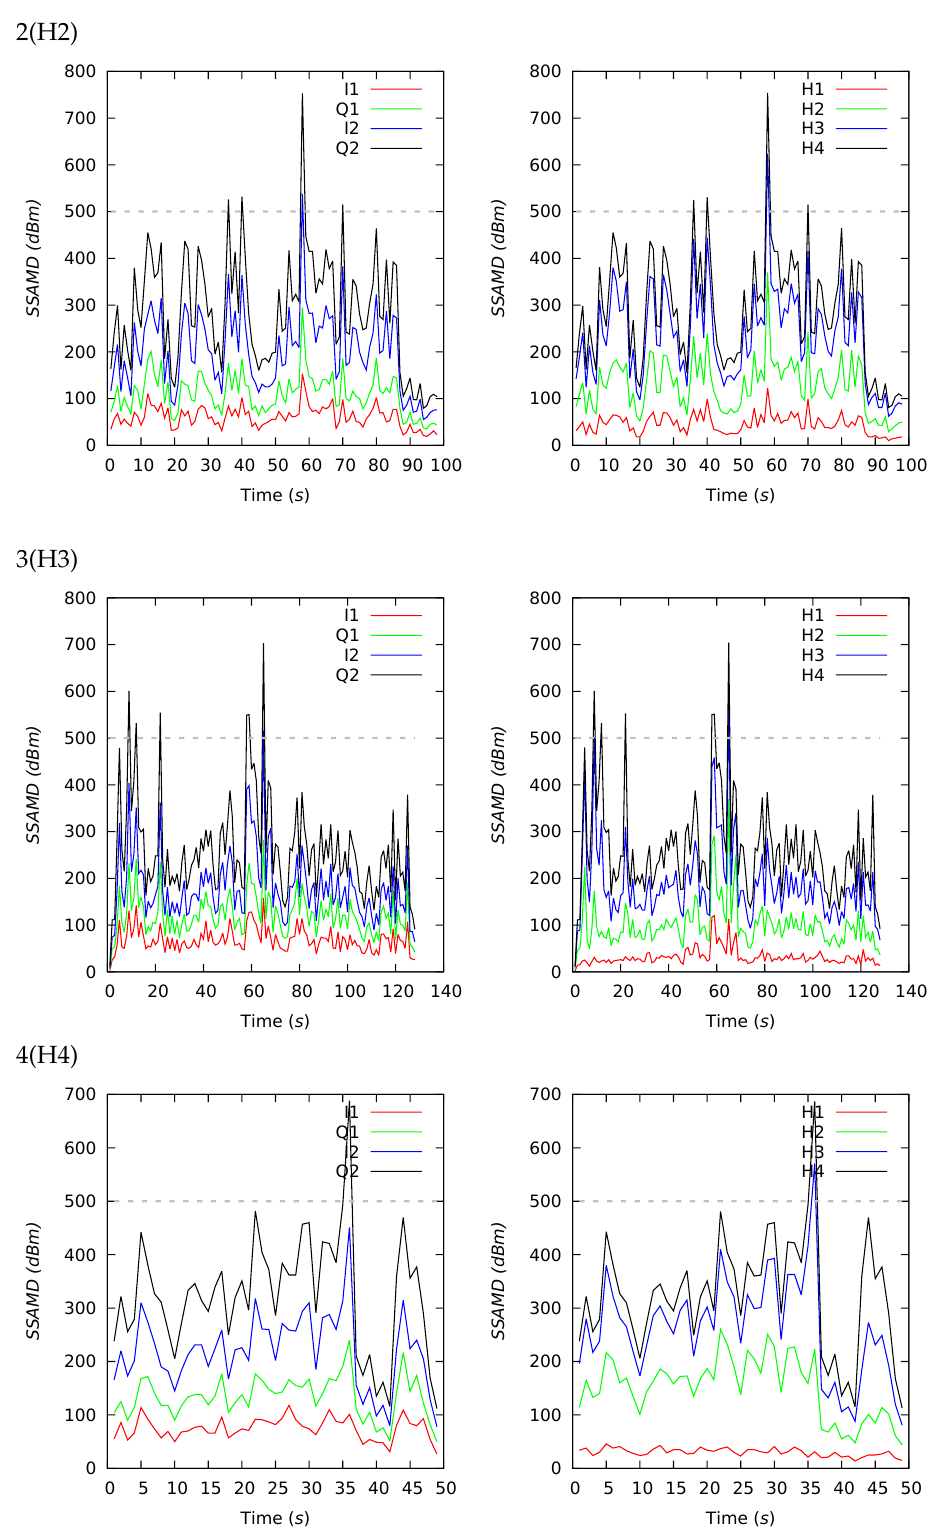
Figure A9. Experiment I, Phryganea grandis 1–4